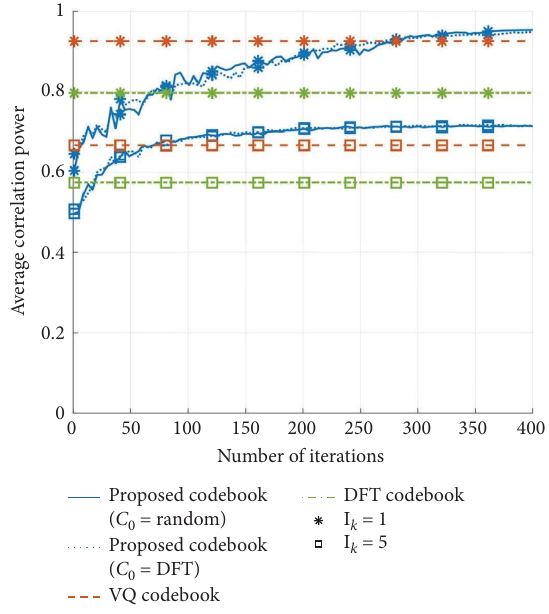
Figure 7: Average correlation power versus the number of